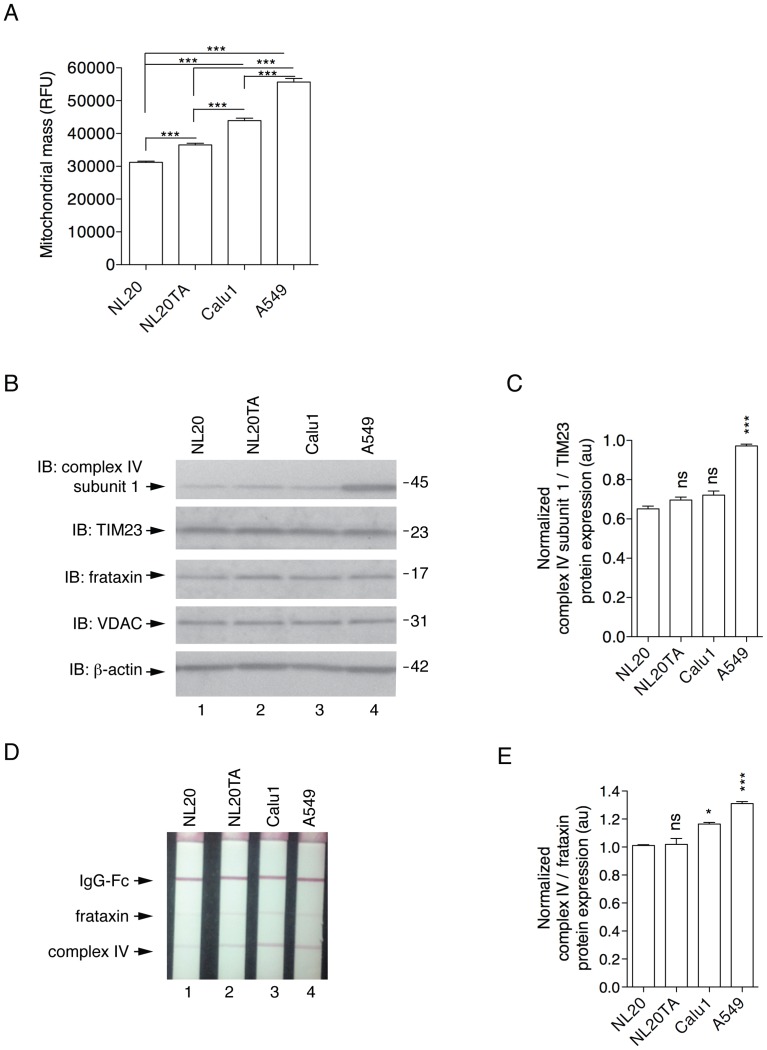
Mitochondrial mass of lung epithelial cells.(A) Mitotracker green fluorescence relative fluorescence units (y-axis, RFU) represents mitochondrial mass (mean and SEM); measurements (n = 8 wells) from three independent experiments. 1-way ANOVA analysis with Tukey post-tests (P<0.0001). (B) Representative immunoblots demonstrating expression of endogenous proteins complex IV subunit I, TIM23, frataxin, and VDAC in NL20 (lane 1), NL20TA (lane 2), Calu1 (lane 3), and A549 (lane 4) cells. β-actin is shown for loading. Markers in kilodaltons (kDa). (C) Immunoblots from two independent experiments were quantified to show relative complex IV subunit I protein expression normalized to TIM23. Mean and SEM shown. 1-way ANOVA analysis with Tukey post-tests compared to NL20. (D) Representative mitochondrial biogenesis dipstick ELISA assay showing frataxin and complex IV expression. (E) Three independent mitochondrial biogenesis ELISA assays were quantified to show relative mitochondrial-encoded complex IV protein expression normalized to the nuclear-encoded frataxin protein. Mean and SEM shown. 1-way ANOVA analysis with Tukey post-tests compared to NL20.